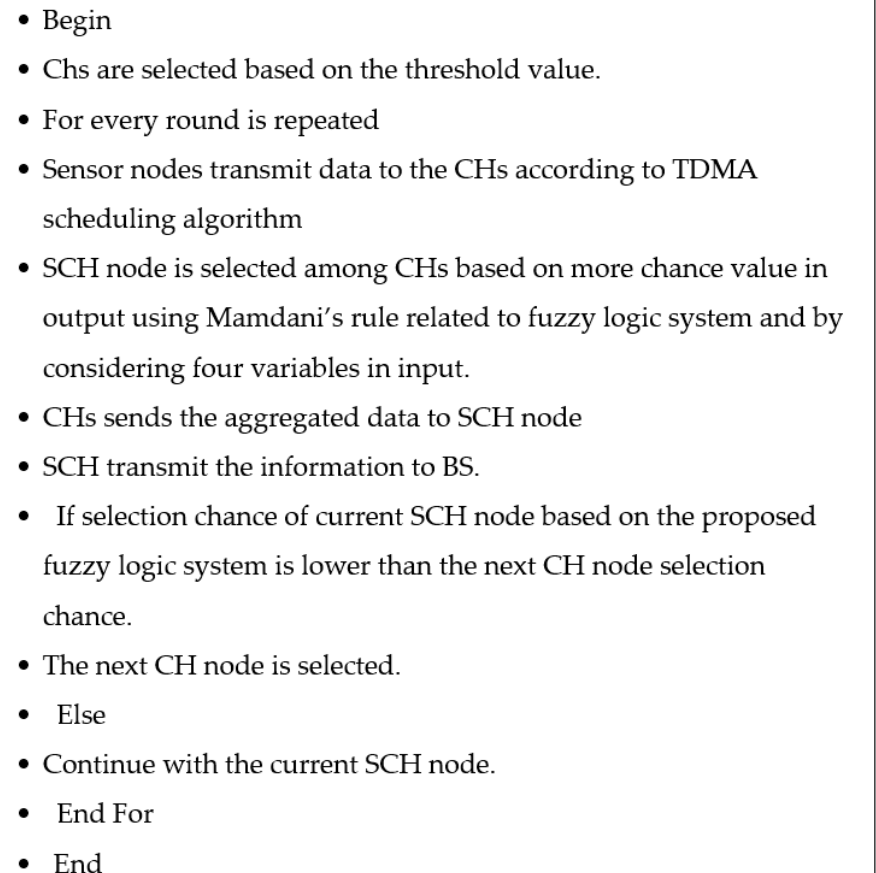
Figure 3. MB-FLEACH algorithm [4].